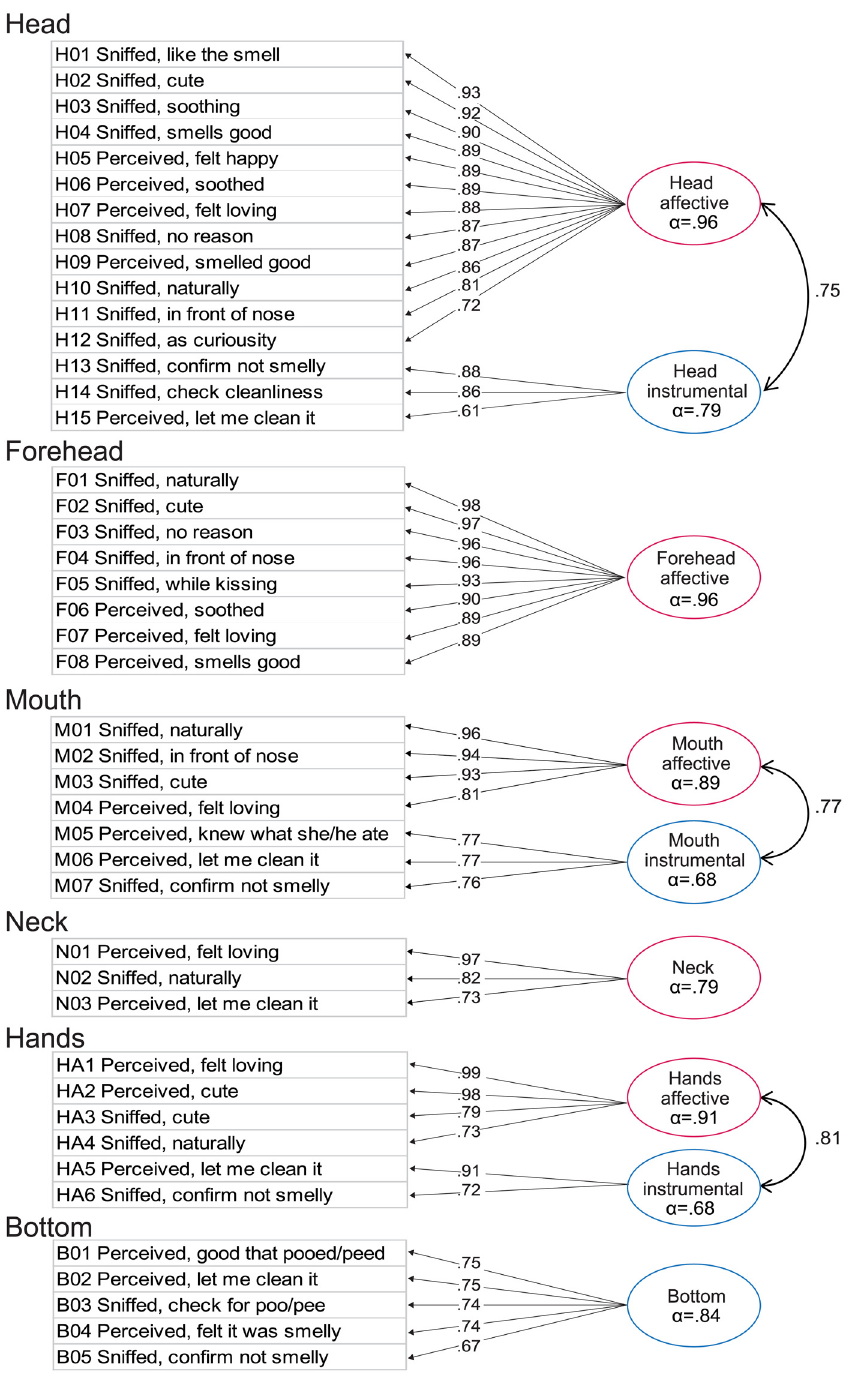
Fig 2. Factor structure of the Child Odor in Parenting scale (COPs) ( n = 888). Abbreviated questionnaire items, standardized factor loadings, and correlation coefficients are presented for each body part. Item number corresponds to those shown in Table 1. Information on model fit for the selected models as well as for the alternative models is provided in S1 Table. Instrumental factors are shown in blue, and the Affective factors are in